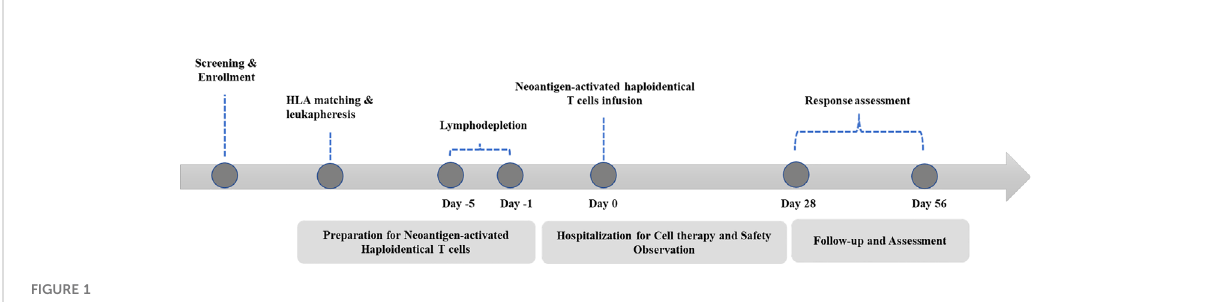
FIGURE 1 Study treatment